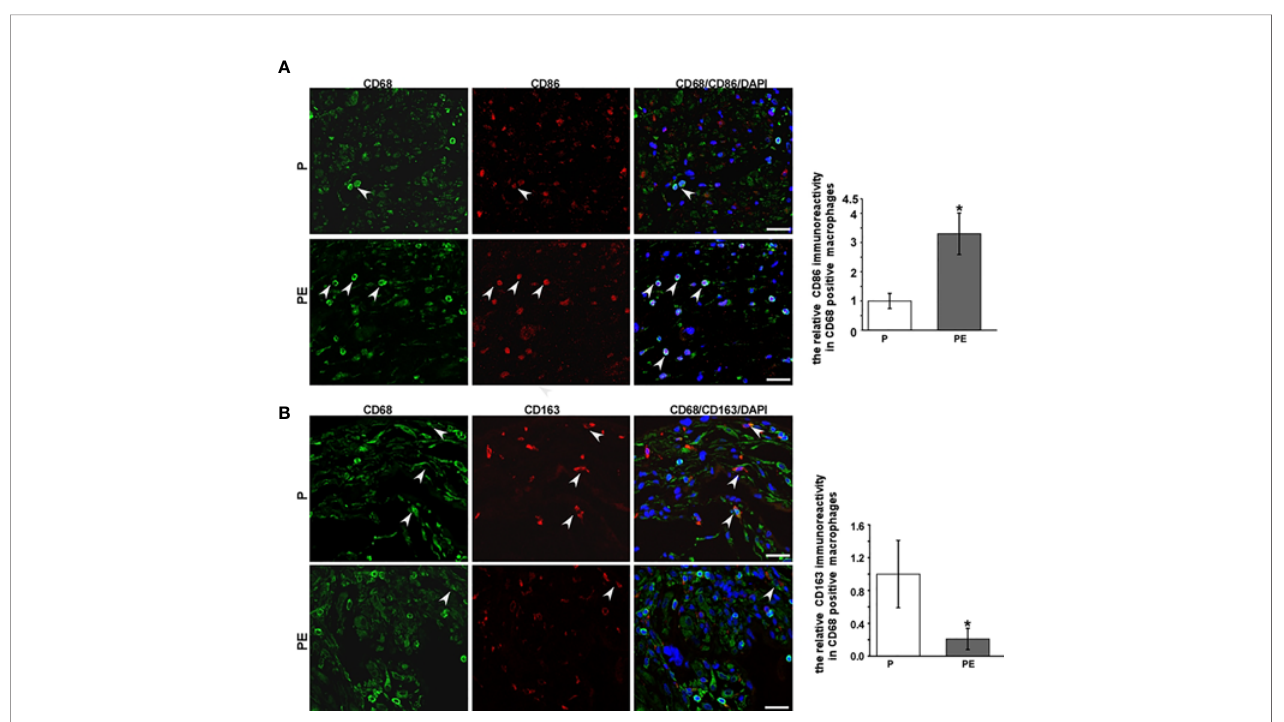
FIGURE 1 | A higher expression of CD86 on decidual macrophages (dM j ) with a lower expression of CD163 on dM j was found in PE patients. (A) Representative immuno fl uorescence images of CD86 (M1 biomarkers) on dM j in PE patients and normal controls; the relative CD86 positive CD68 immunoreactivity was quanti fi ed as shown in the graph. CD68 was stained as pan-macrophage biomarker. White arrows indicated positive stained signals. (B) Representative immuno fl uorescence images of CD163 (M2 biomarkers) on dM j in PE patients and normal controls; quanti fi cation for the relative CD163 positive dM j immunoreactivity was shown in the graph. White arrows indicated positive stained signals. Scale bar=30 m m.*P <